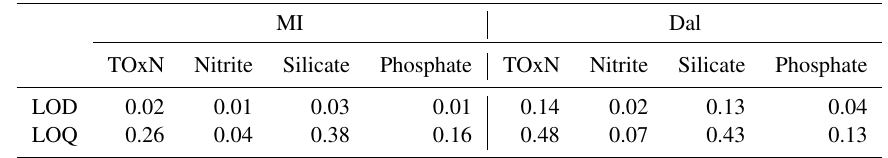
Table 4. The limit of detection (LOD) and limit of quantification (LOQ) in µmolL − 1 for both instruments. MI